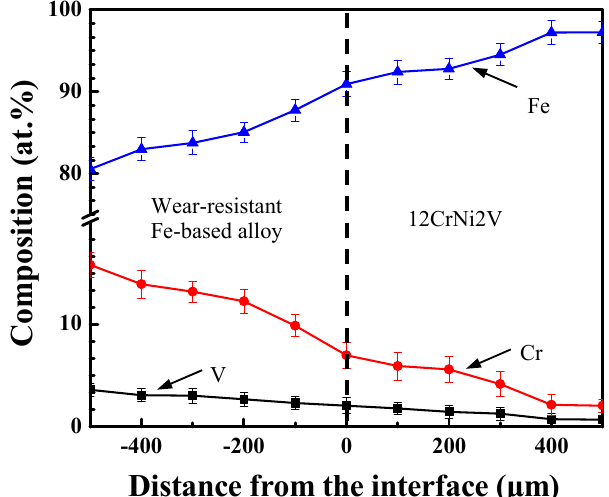
Figure 6. Composition near the interface of the laser melting deposited Fe-based alloy gradient materials.